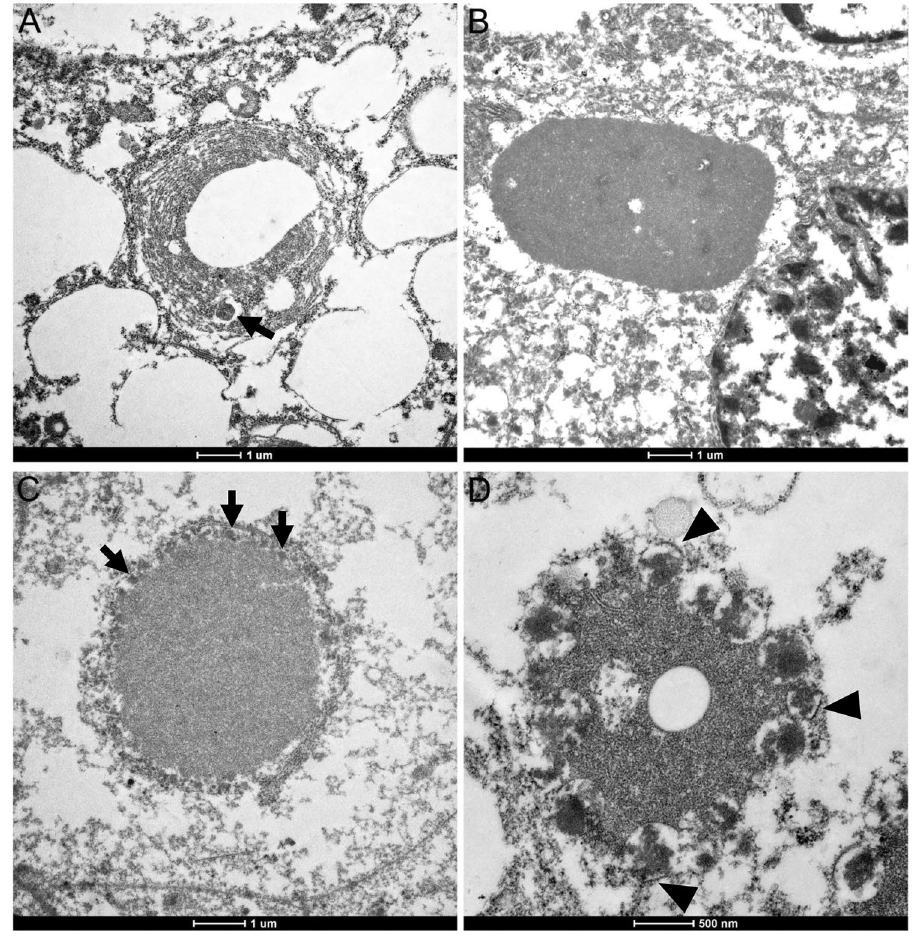
Figure 2. Transmission electron micrographs of ECIs in RCCs. ( A ) An ECI exhibiting a concentric membranous structure with lipid or clear spaces; note the round electron-dense structure within the concentric membranous structure (arrow). ( B ) An ECI consisting of proteinaceous material with several clear spaces within it. ( C ) An ECI comprising proteinaceous material with electron-dense structures (arrows) completely enclosing it. ( D ) An ECI displaying aggregates of fibrillar components and single membrane-bound electron- dense structures